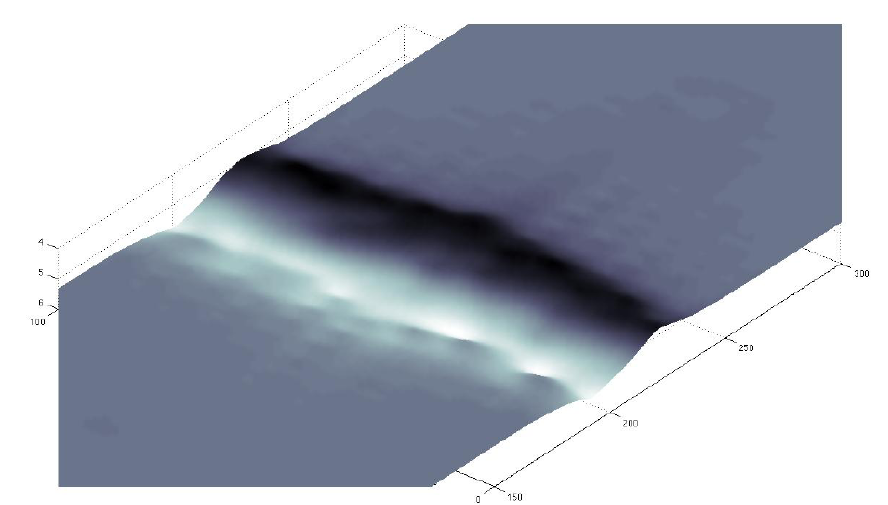
Figure 6. Scouring under a sluice